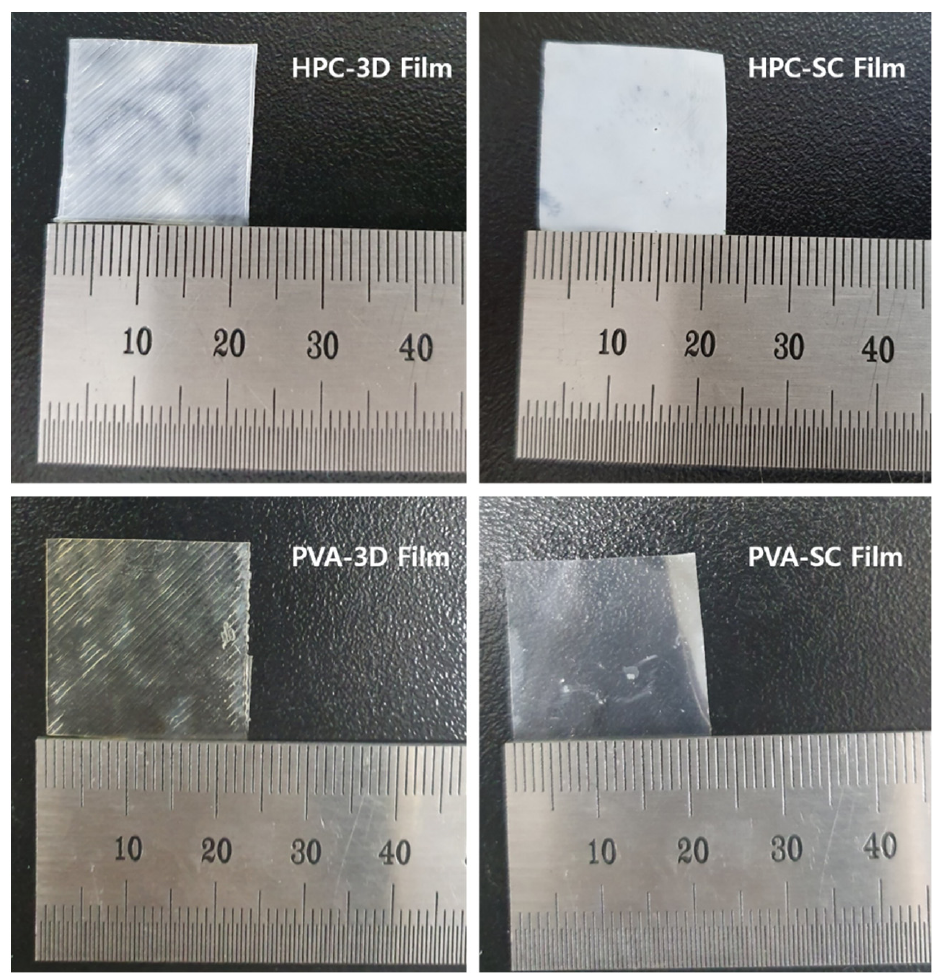
Figure 5. Photographs of the 3D-printed films and solvent-cast films. The interlayer spaces and the porosity of 3D-printed films were generated by the layering process of 3D printing (Figure 6). Scanning by AFM determines the roughness of a sample surface, visualizing the roughness of the sample surface that can be expressed as the root mean square (RMS) of the roughness (Rq) value of the 3D-printed and solvent-cast films (Figure